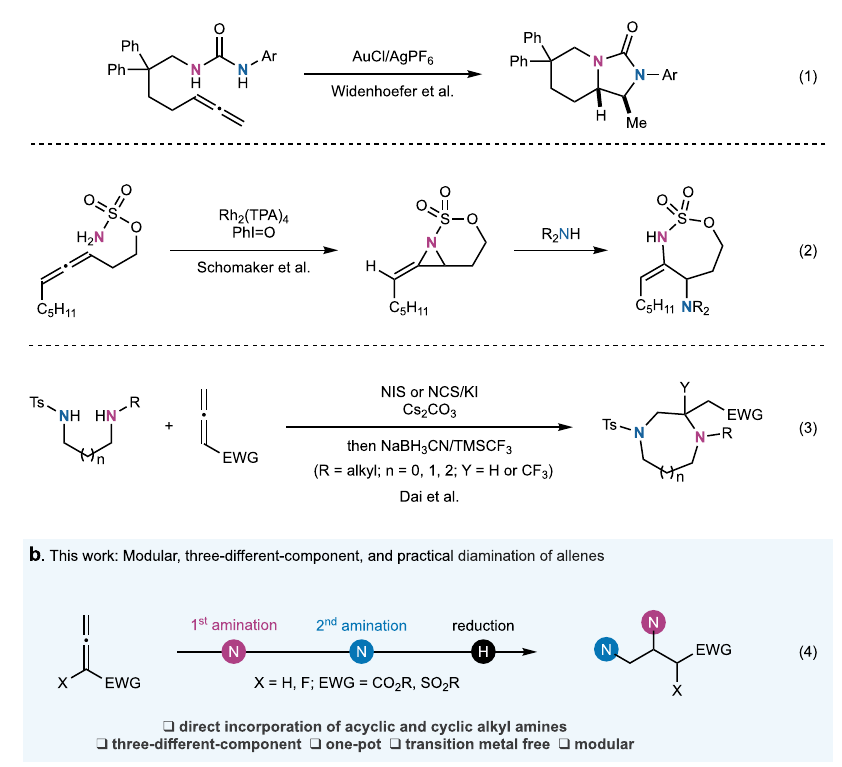
Fig. 1 | Diamination of allenes. a Previous diaminative cyclization of allenes. b Our method: Modular and practical diamination of allenes with two different